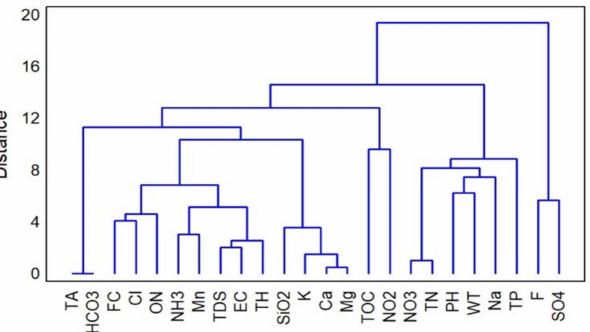
Figure 9. Hierarchical cluster analysis for groundwater quality parameters monitored in the Cuer- navaca aquifer from 2012 to